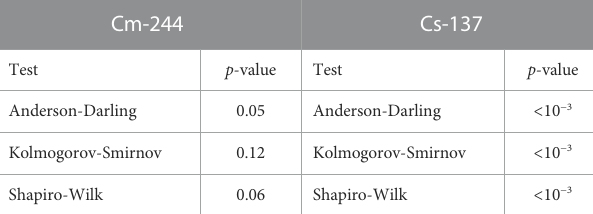
TABLE 2 Statistical tests to check if distribution of (C/E-1) for 244 Cm and 137 Cs in Figure 6 is consistent with a Gaussian distribution. Cm-244 Cs-137